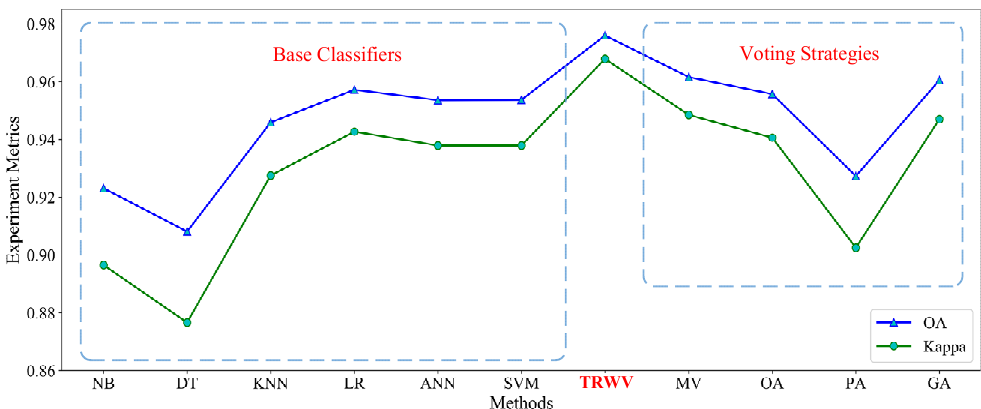
Figure 10. Comparisons of the experimental metrics by the base classifiers and the ensemble learning method with multiple voting strategies on Image I.